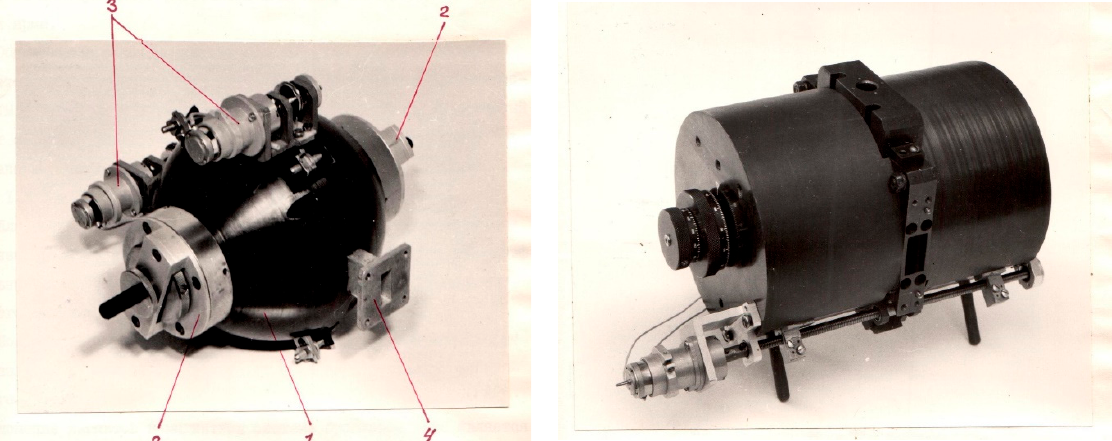
Figure 3. Two models of permanent magnet-based magnet blocks for benchtop EPR spectrometers. A piece of waveguide of X-band EPR spectrometer in the left photo indicates the miniature size of the magnet. The diameter of cylindrical magnet block in the right photo is 14 cm. 1 —magnet yoke, 2 —magnetic field adjustment mechanism, 3 —frequency tuning and coupling nodes of the measuring resonator, 4 —lead-in waveguide. Source: personal archive of V.N. Linev.